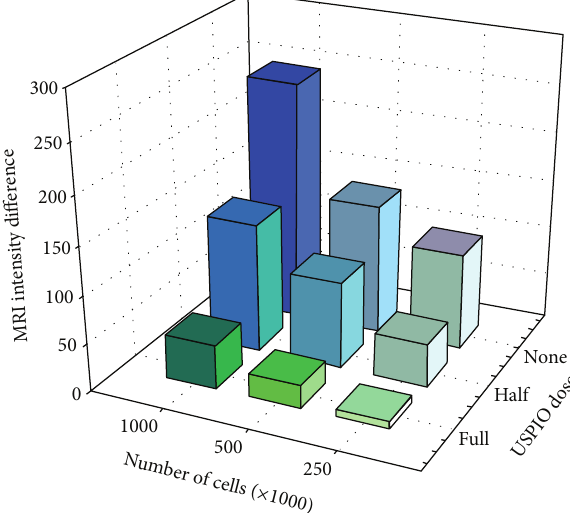
Figure 3: Absolute phantom MRI intensities after 21 hour USPIO incubation. MRI intensities are absolute mean values. USPIO: ultrasmall superparamagnetic iron-oxide. USPIO dose: full = 10 𝜇 g per 10 5 cells; half = 5 𝜇 g per 10 5 cells.